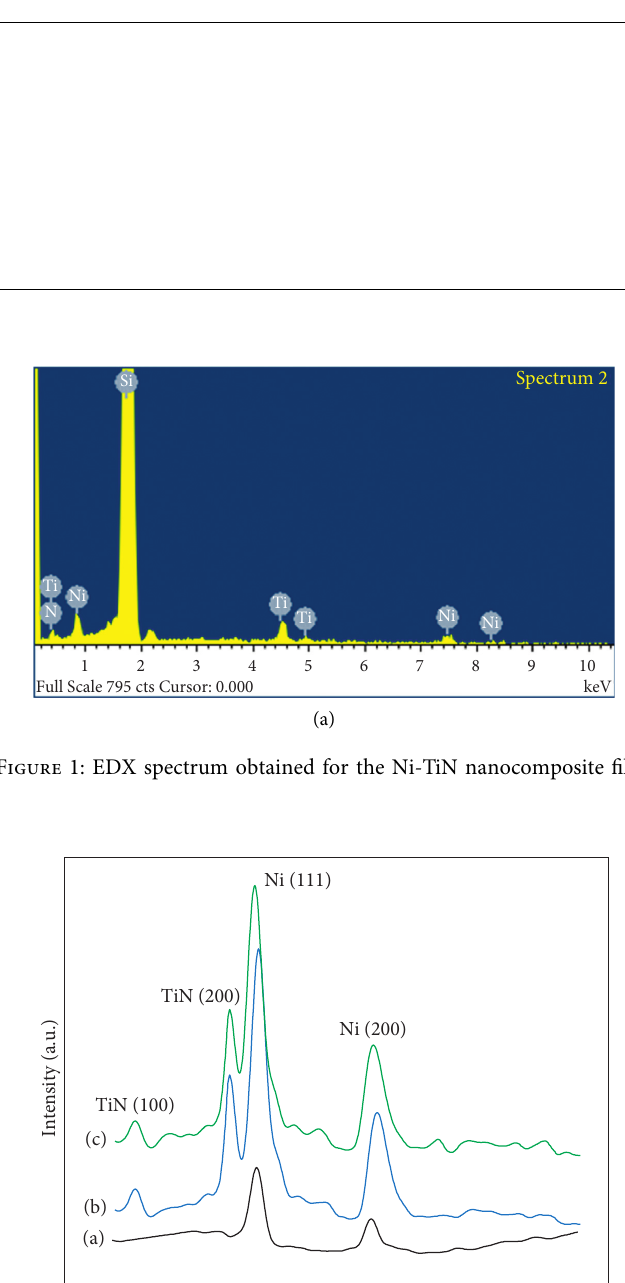
90 Cu 10 -TiN thin films.